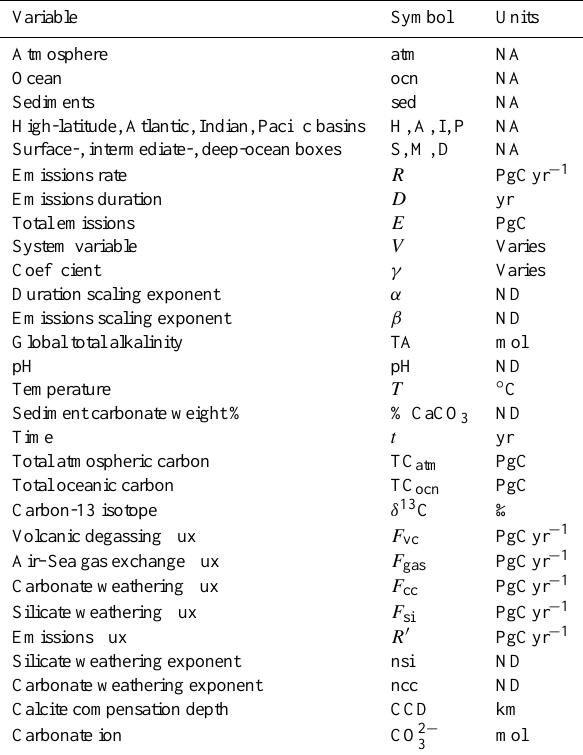
Table 3. Variable definitions and symbols used. Variable